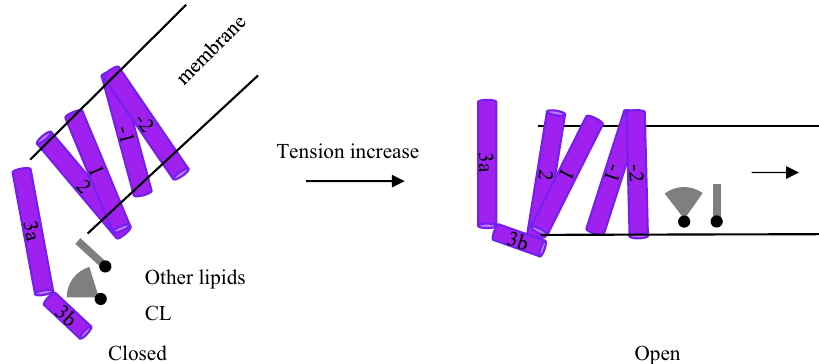
Fig. 6 Proposed mechanosensing mechanism of YnaI. When tension increases, the membrane curvature around the closed YnaI decreases, which promotes two actions: lipids leaving the paddle pockets and the paddles switching their conformation. These actions lead to the movement of pore lining TM3a and opens the